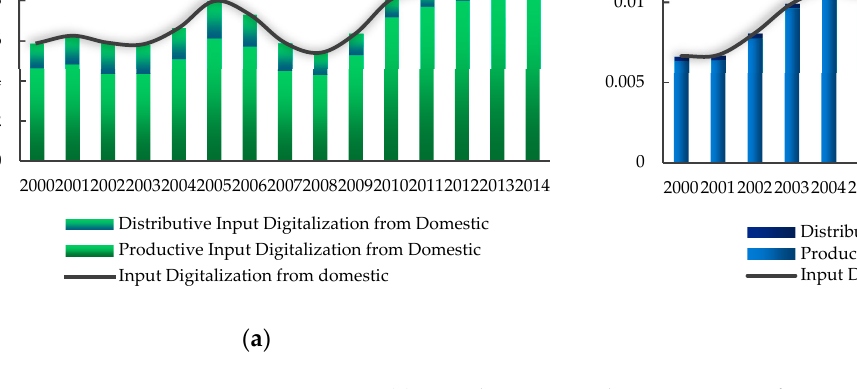
Figure 4. ( a ) Development and composition of input digitalization from domestic sources; ( b ) De ‐ velopment and composition of input digitalization from foreign